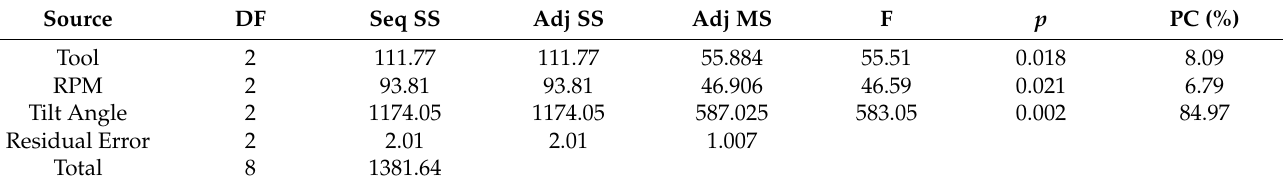
Table 9. Analysis of variance for means.